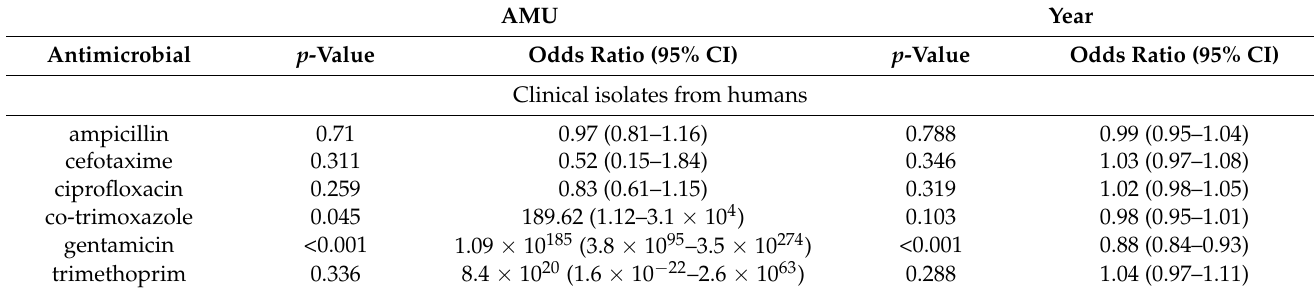
Table 4. Association of year and antimicrobial use with AMR to different antimicrobials in the populations. Results of univariable logistic regression